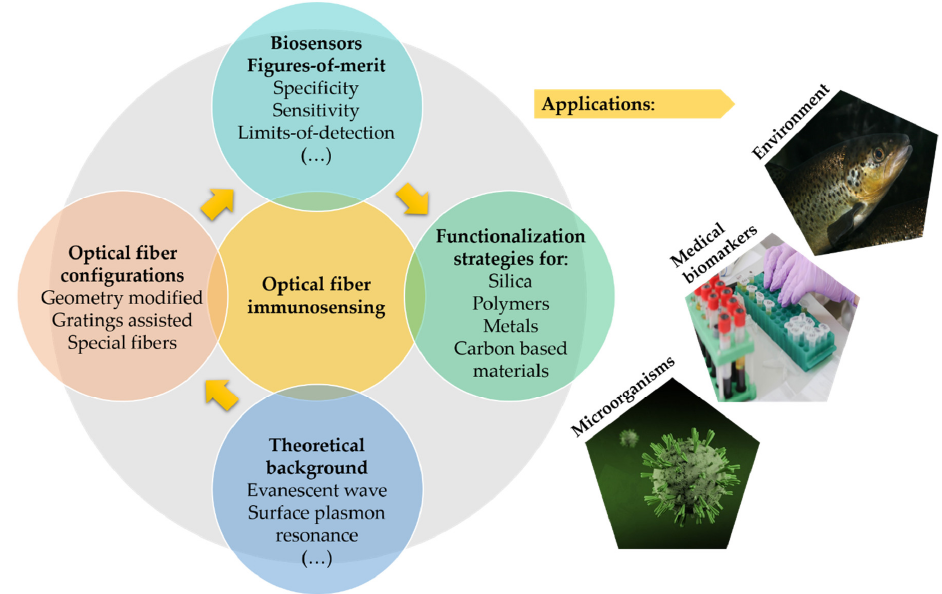
Figure 1. Schematic illustration of the main contents on this review.